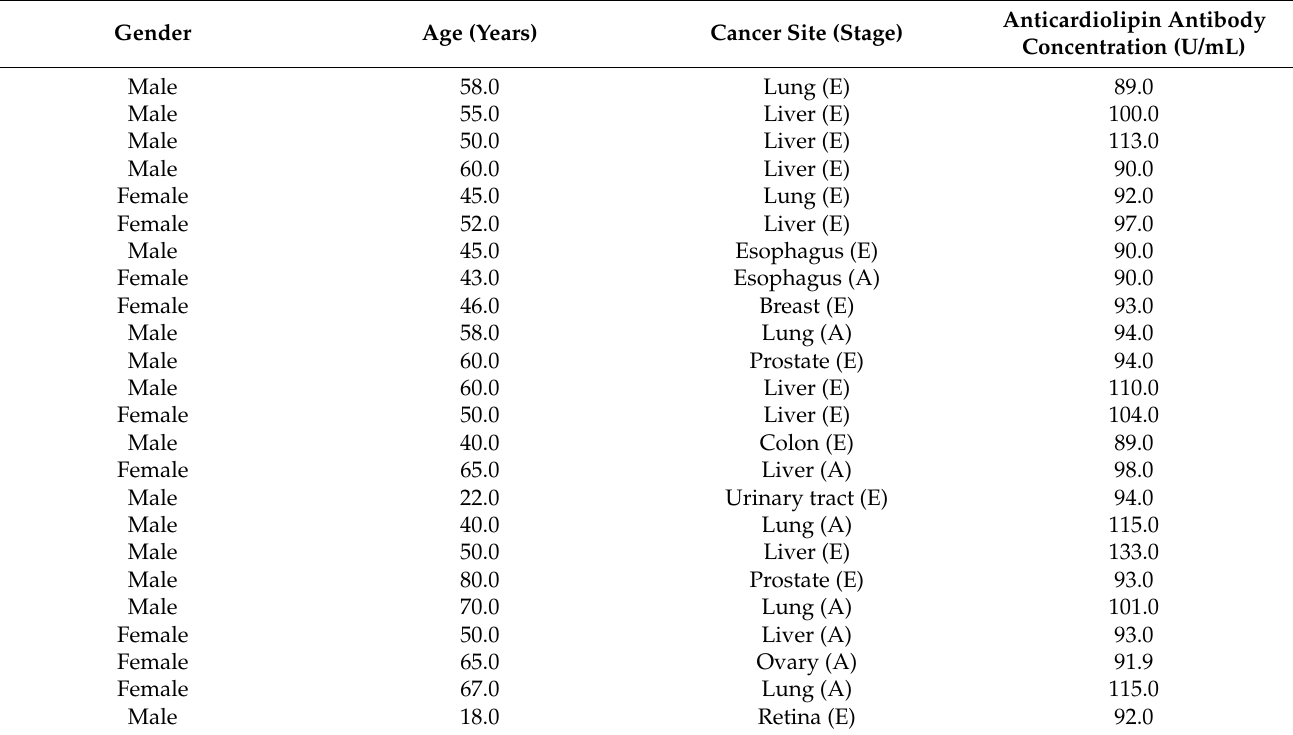
Table 3. Individual profile of anticardiolipin-antibody-positive cancer